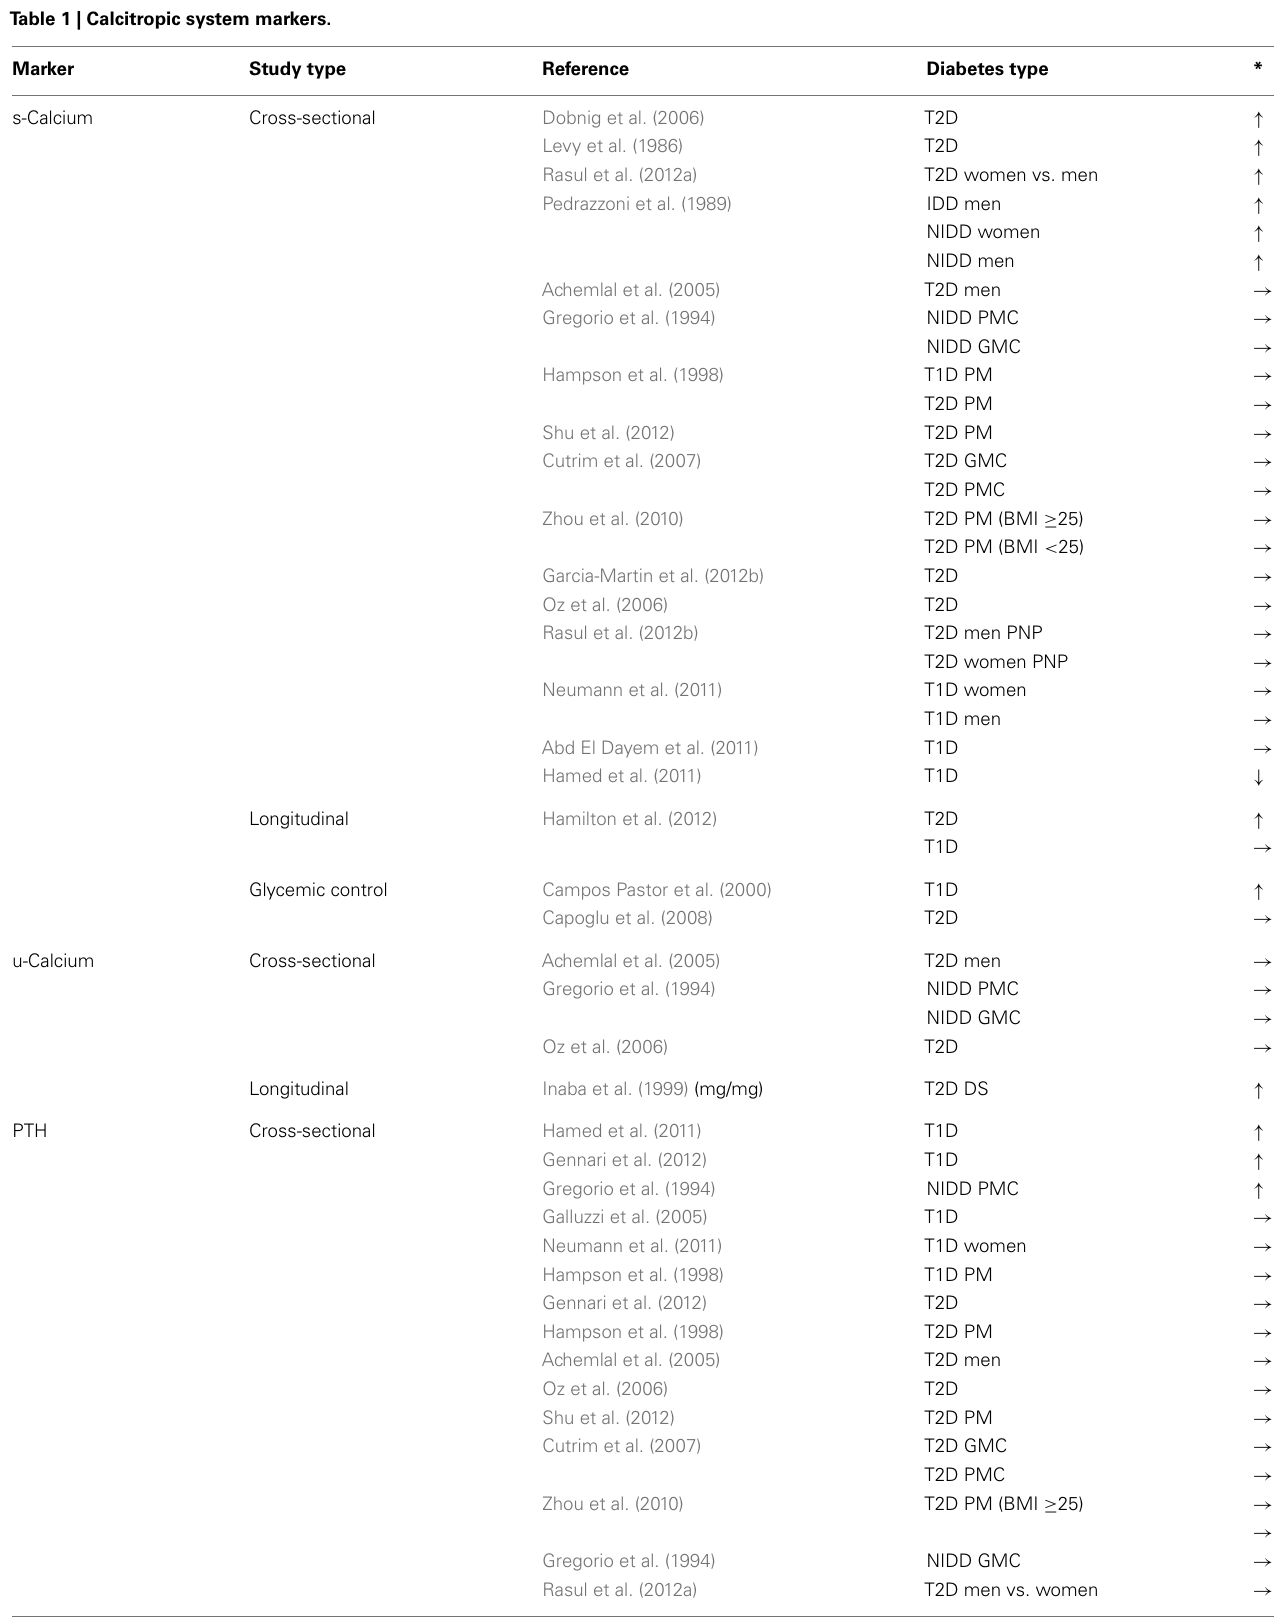
Table 1 | Calcitropic system